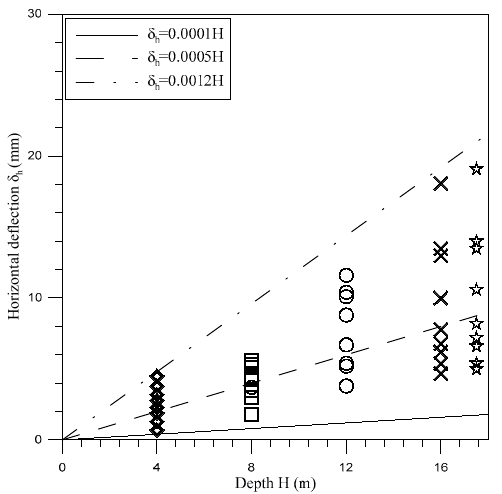
Figure 19. Deflection of retaining wall versus excavation depth (nodes 23–31).